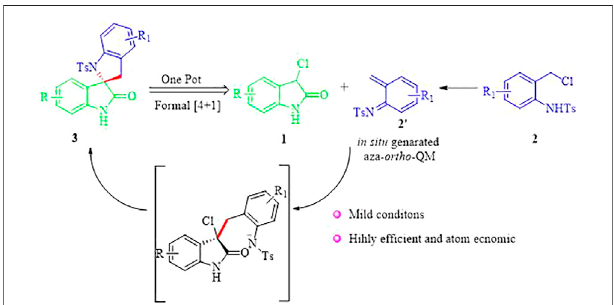
TABLE 1 | Reaction condition optimization studies.